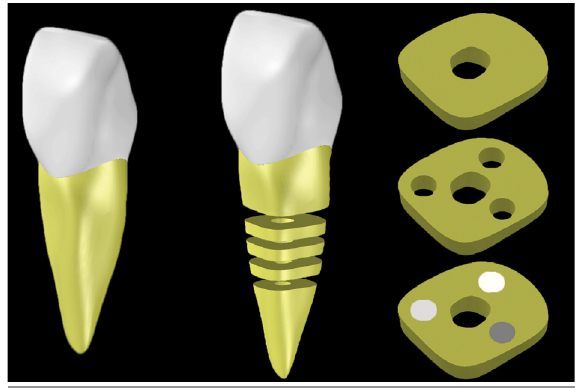
Figure 1. Schematic representation of the root slice acquisition and